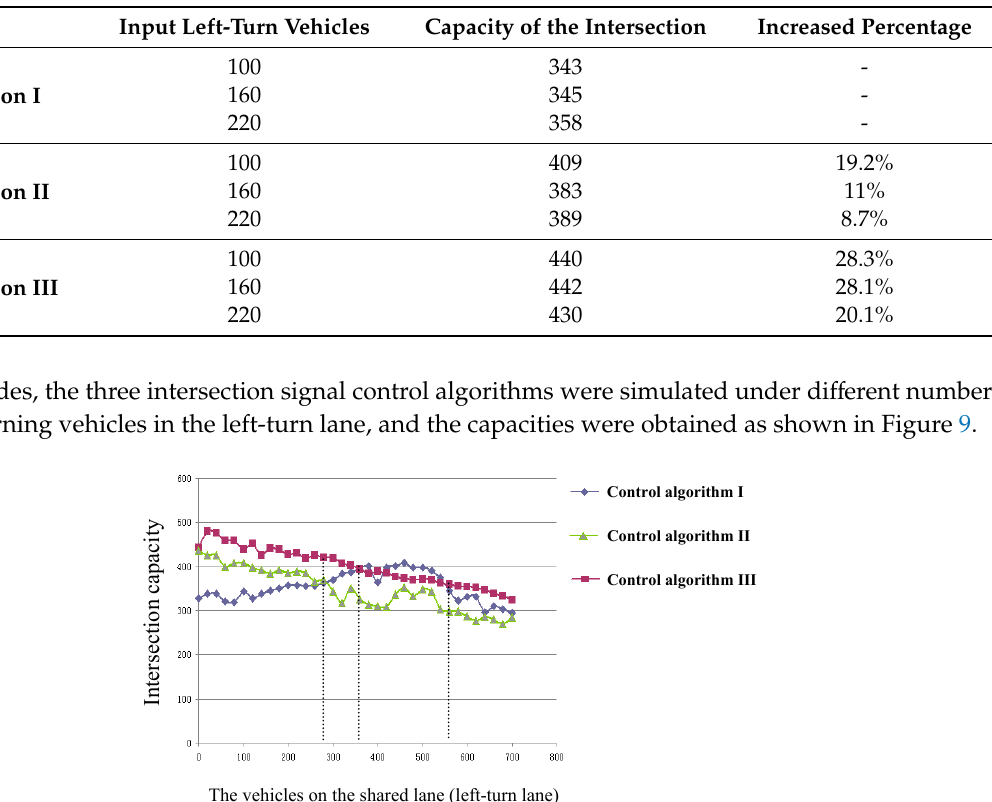
Table 1. The simulation results.